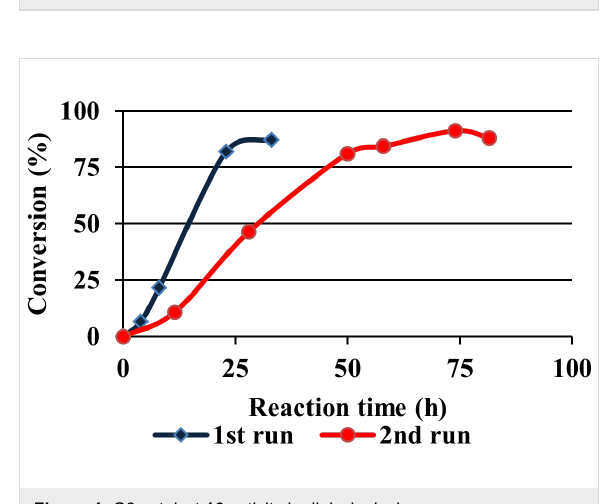
Figure 3: Reaction setup to perform compartmentalized catalysis.